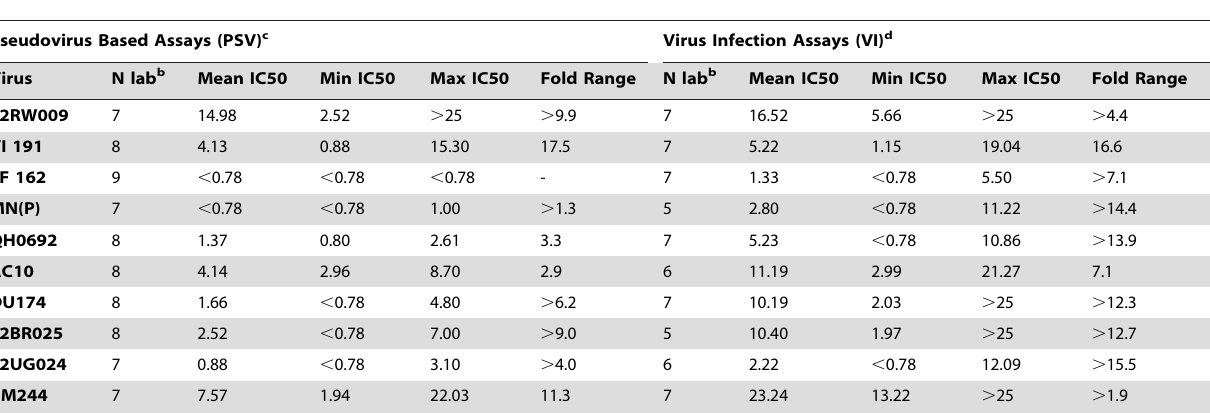
Pseudovirus Based Assays (PSV)